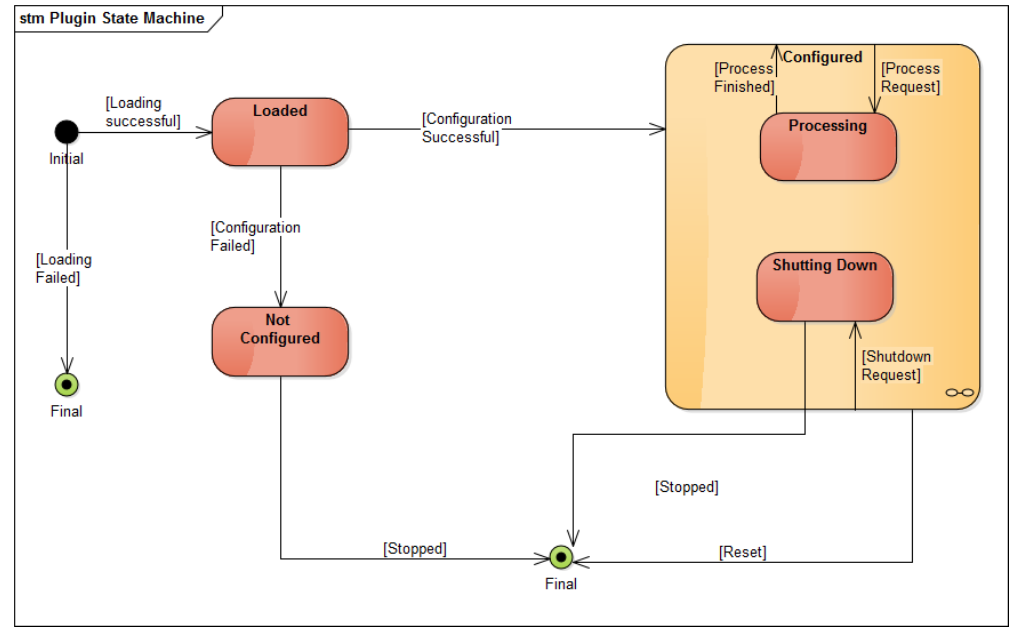
Figure 6. UML diagram showing the state machine underlying each world model